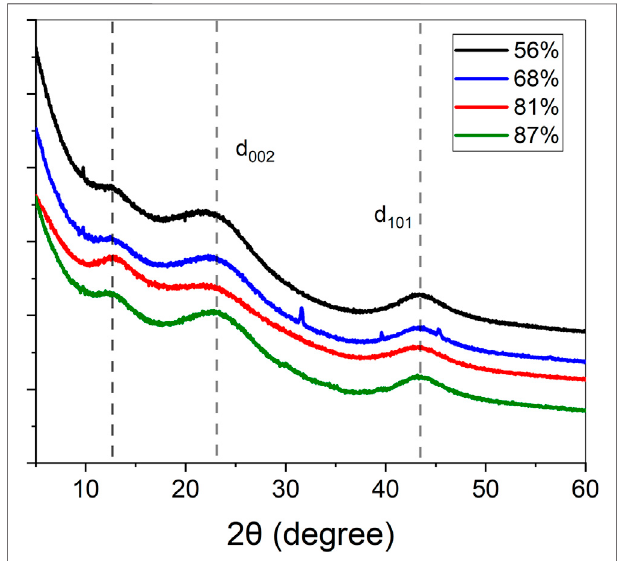
FIGURE 3 | X-ray diffraction patterns of lignin carbon aerogels with different crosslinker-to-lignin ratios corresponding to 44, 68, 81, and 87 wt% of